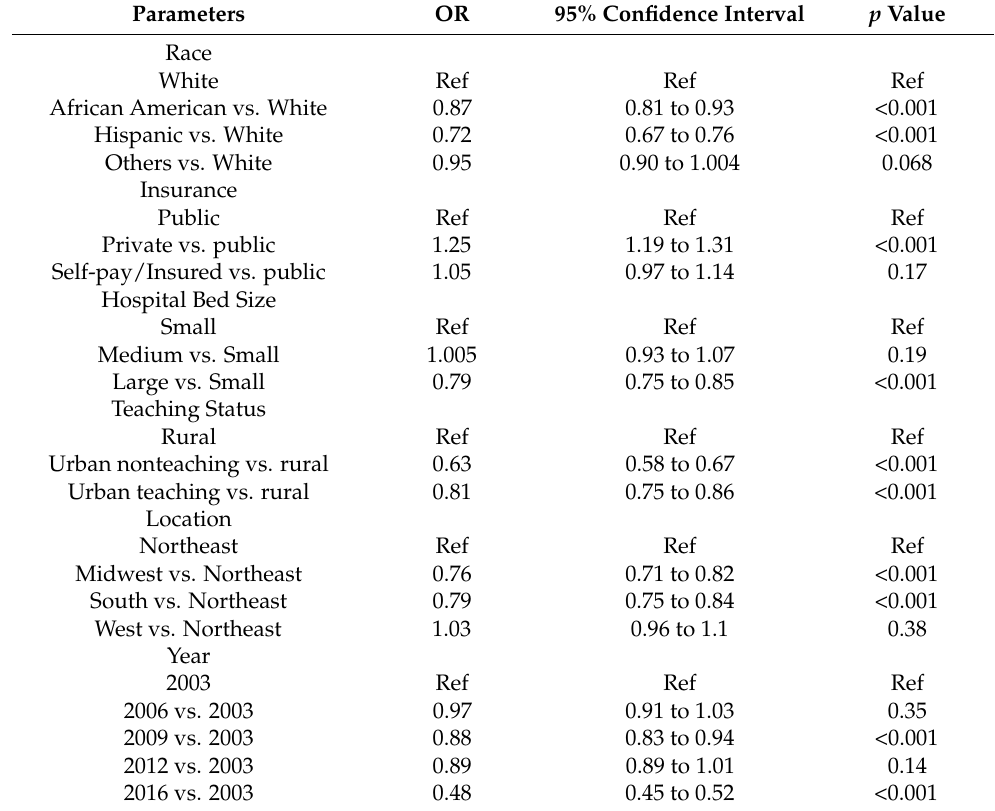
Table 3. Multivariate logistic regression model demonstrating the association between various demographic factors, comorbid conditions and CVS hospitalizations. Parameters OR 95% Confidence Interval p Value Race White African American vs. White Hispanic vs. White Others vs. White